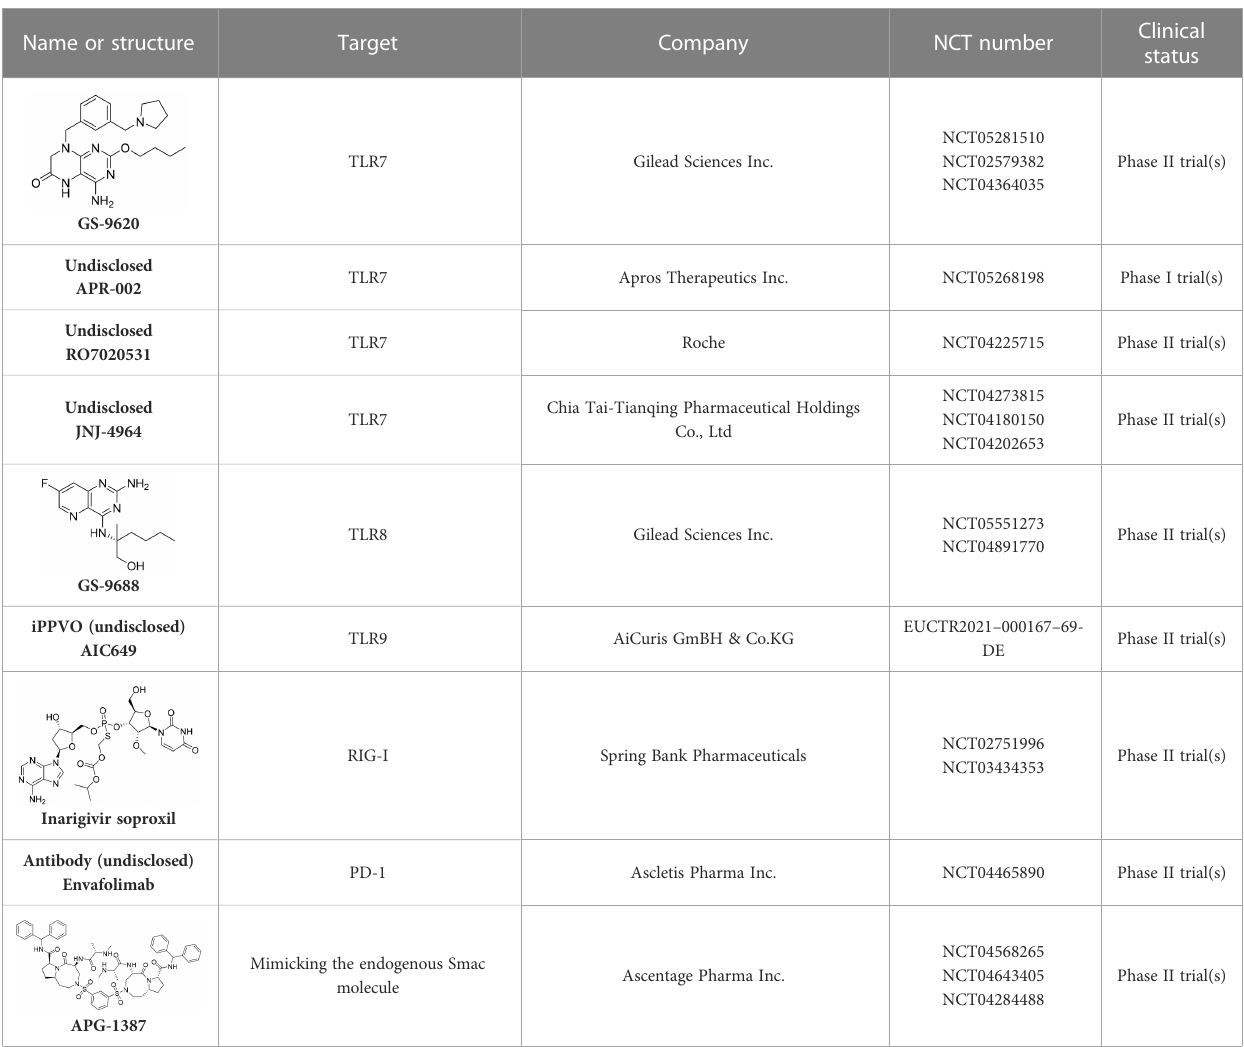
TABLE 7 The summary of compounds modulating the host immune